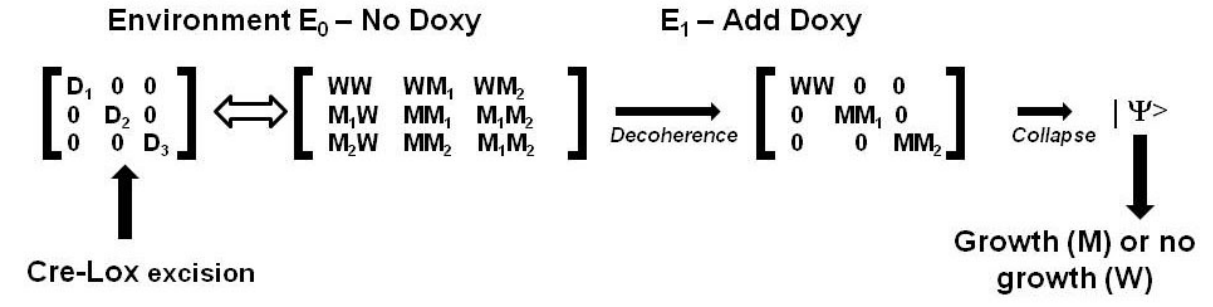
Figure 5. Quantum representation of the experimental design resulting in adaptive mutation. The “D” states represent preferred cell states in an environment lacking doxycycline and after CRE-Lox excision. The “W” states represent the cell state that is wild type from the perspective of the original inactive polyA site, whereas the “M” states represent cell states in which mutation (eg, the polyA site) allows for cell growth in the presence of